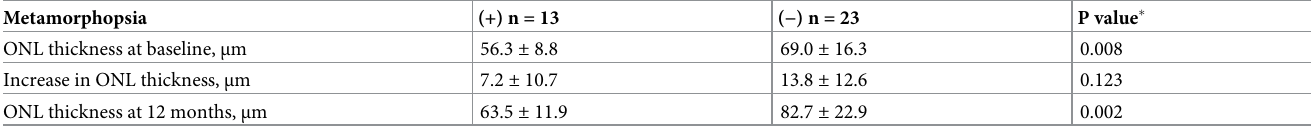
Table 6. Outer nuclear layer thickness with or without metamorphopsia at 12 months. Metamorphopsia